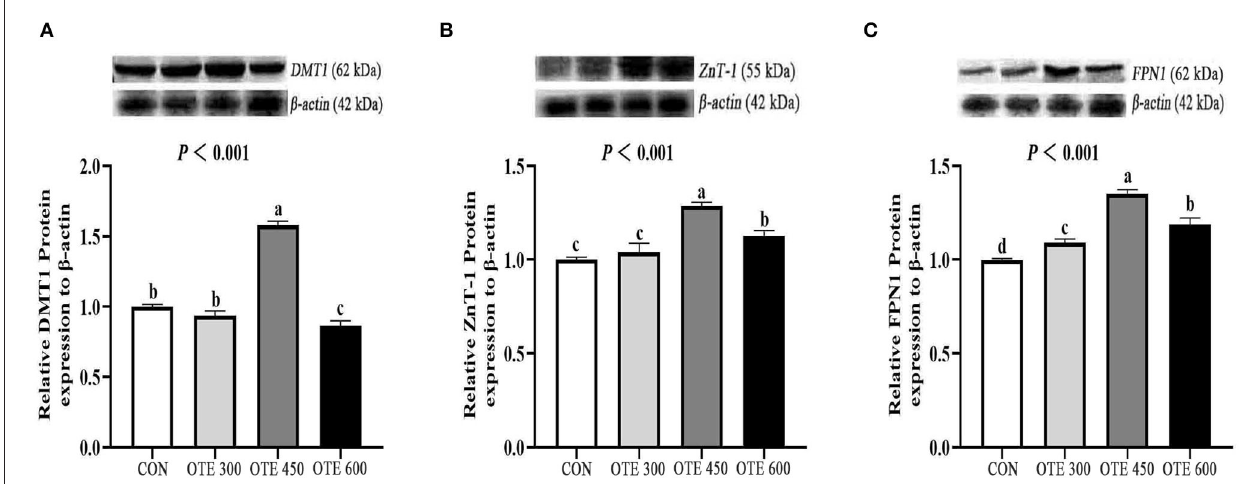
FIGURE 6 | Efects of organic trace elements on protein expression of duodenal trace element transporter in late-phase laying hens. DMT1 (A) , divalent metal transporter 1; ZnT-1 (B) , zinc transporter; FPN1 (C) , ferroportin 1. Different letters represent significant differences ( p <